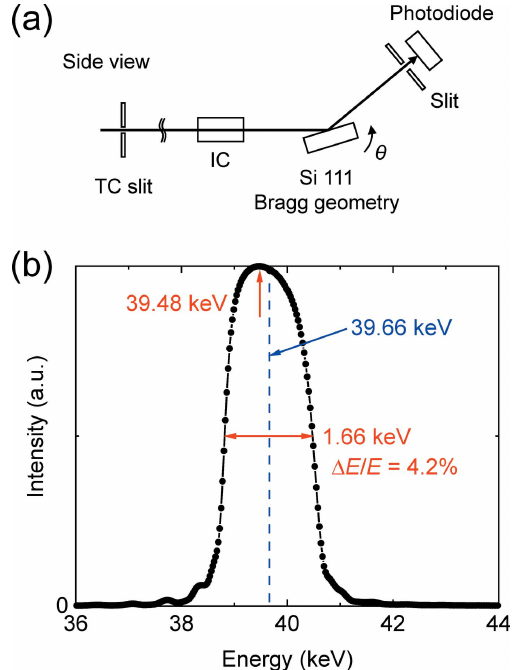
Figure 9 ( a ) Schematic of the spectrum measurement for the 40 keV DMM and ( b ) the measured